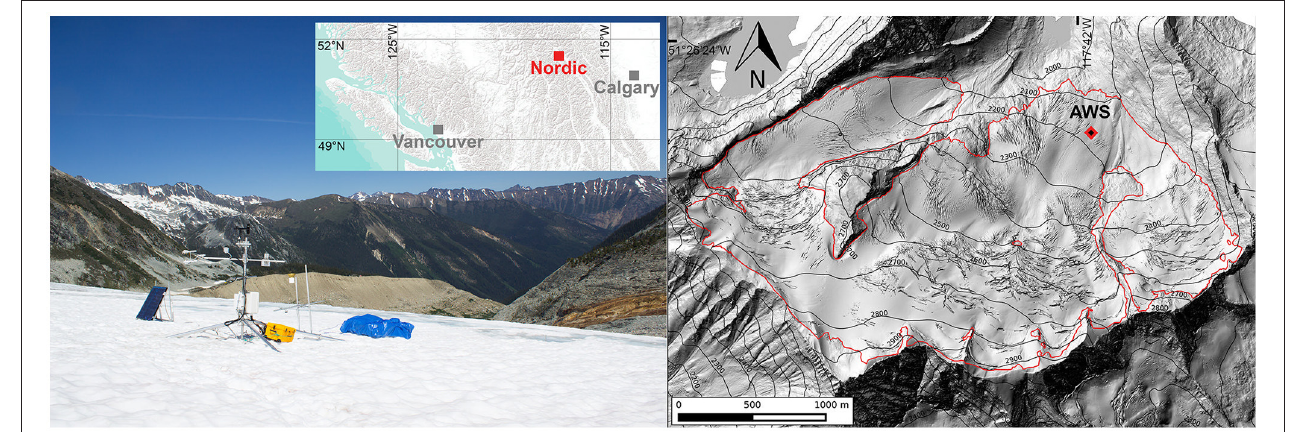
FIGURE 1 | Installed AWS (as viewed by the time lapse camera), and its location on Nordic Glacier (red outline over LiDAR imagery) in the Purcell Mountains, BC, Canada, during the 2014 melt season.